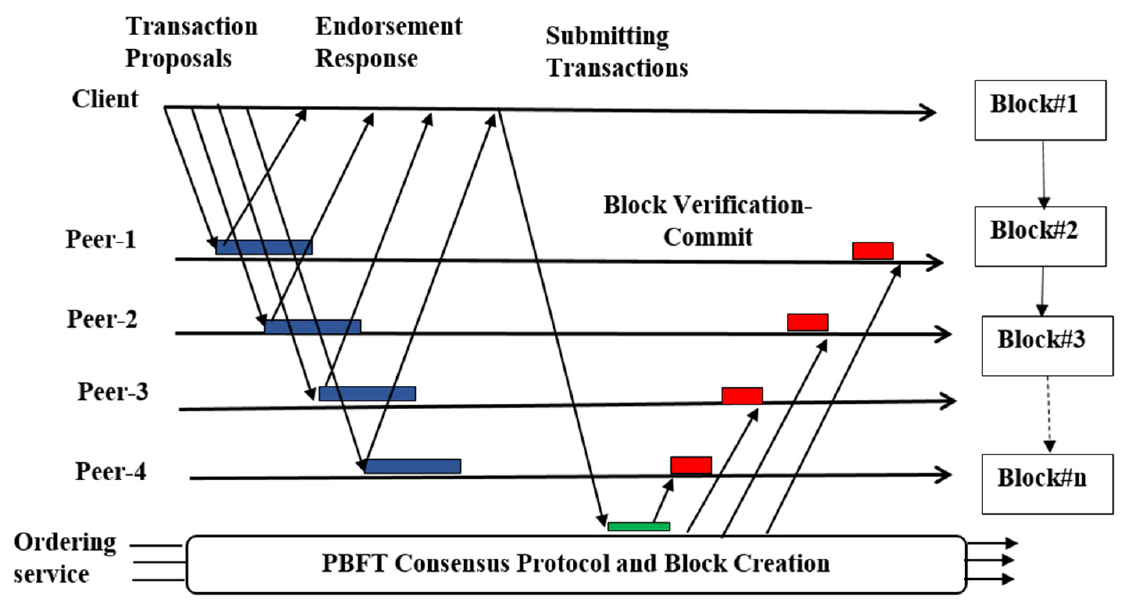
Figure 3. Hyperledger Fabric organization structure integrated with PBFT consensus algorithm.